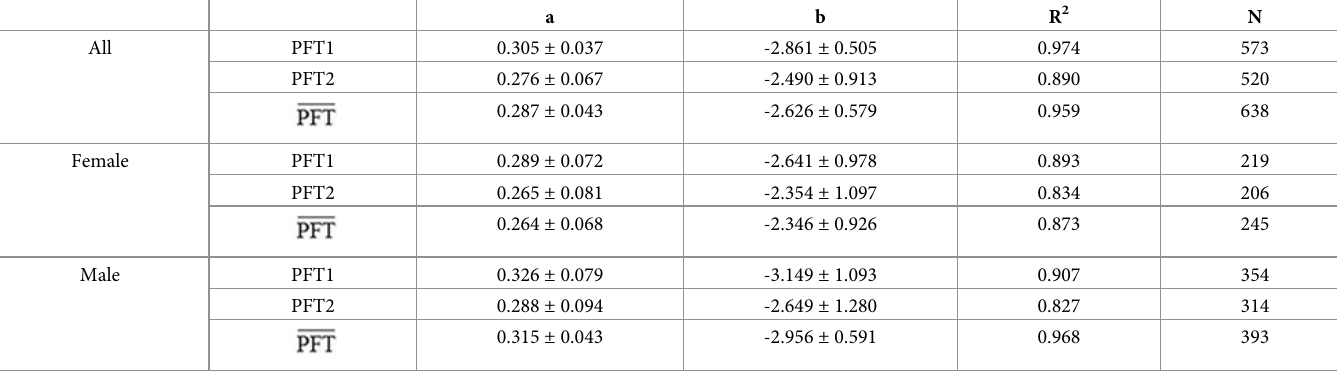
Table 3. The fitting coefficient (a and b), the Goodness of Fit (R 2 ) and the number of athletes (N) in Fig 1A–1C. a b R 2 N All